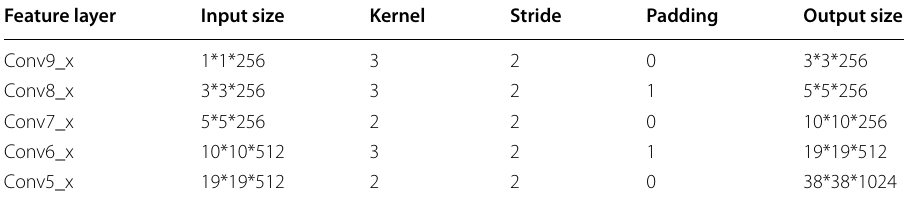
Table 3 Deconvolutional operation parameters Feature layer